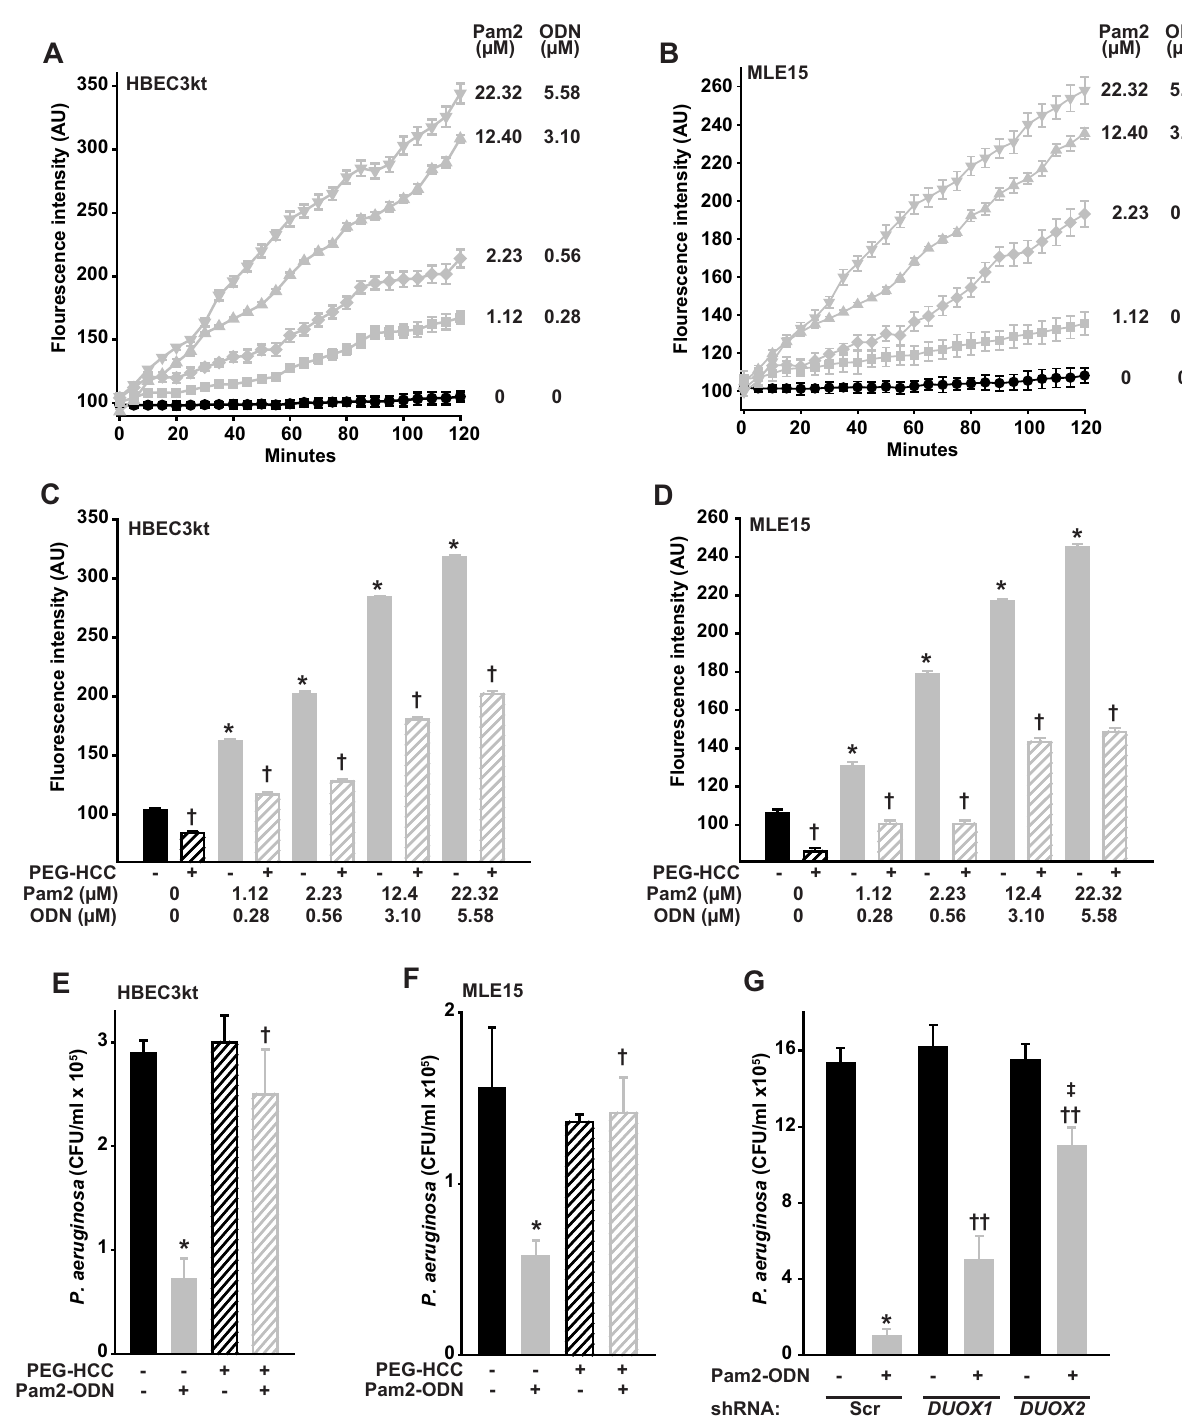
Fig 3. Pam2-ODN induces antibacterial ROS from isolated lung epithelial cells. HBEC3kt ( A ) or MLE15 ( B ) cells were exposed to CO-H 2 DCFDA, treated with the indicated doses of Pam2-ODN, then fluorescence intensity was measured every 5 min. HBEC3kt ( C ) or MLE15 ( D ) cells were pretreated with PEG-HCC or PBS, exposed to CO-H 2 DCFDA, then treated with the indicated dose of Pam2-ODN. Shown are fluorescence intensity 100 min after treatment. HBEC3kt ( E ) or MLE15 ( F ) cells were pretreated with PEG-HCC or PBS, treated for 4 h with PBS or Pam2-ODN (Pam2 2.23 uM, ODN 0.56 uM), then challenged with P . aeruginosa . Shown are culture bacterial burdens 4 h after challenge. ( G ) HBEC3kt cells were stably transfected with scrambled (control) shRNA or shRNA targeting DUOX1 or DUOX2 , then treated with PBS or Pam2-ODN for 6 h prior to P . aeruginosa challenge. Shown are culture bacterial burdens 4 h after challenge. Each panels is representative of at least three independent experiments.